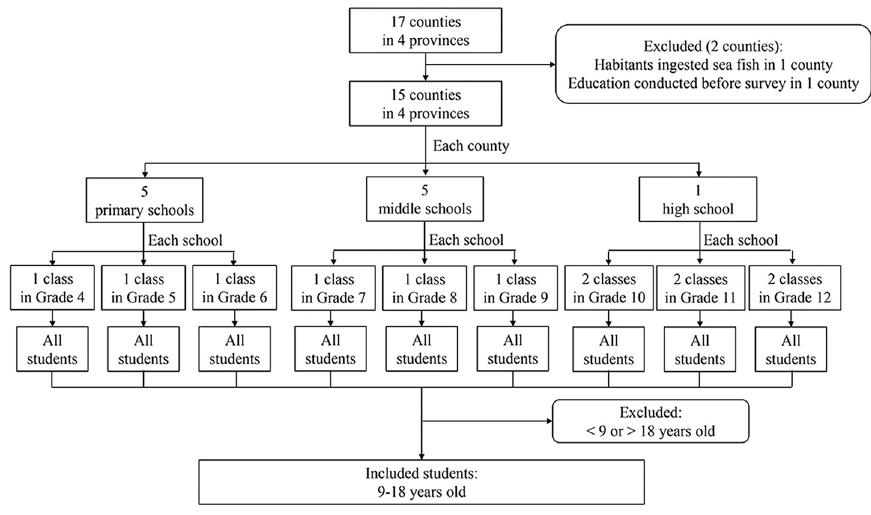
Fig 1. Flow chart of the